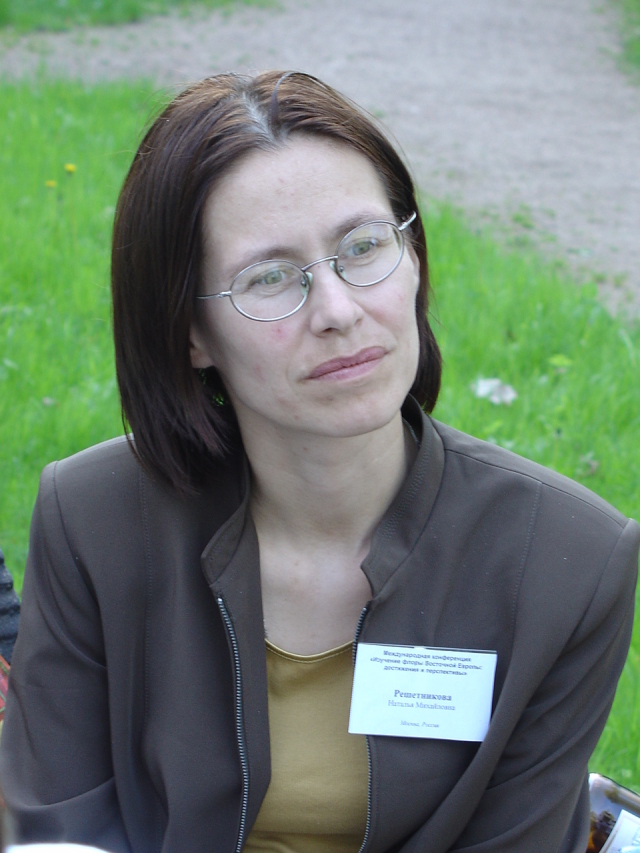
N.M. Reshetnikova